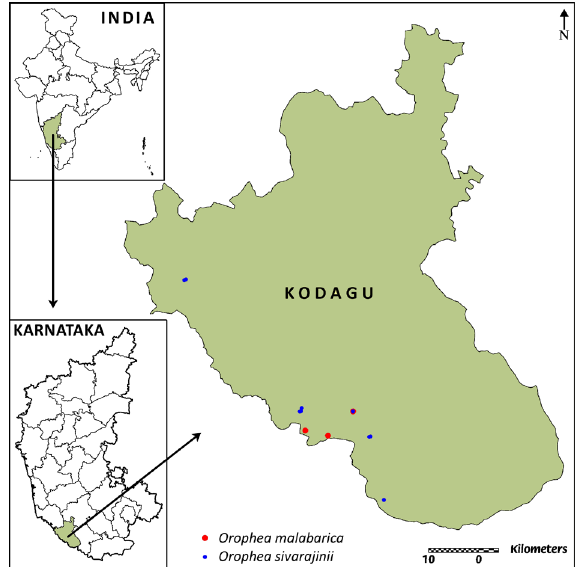
Figure 1. Kodagu District showing the species distribution